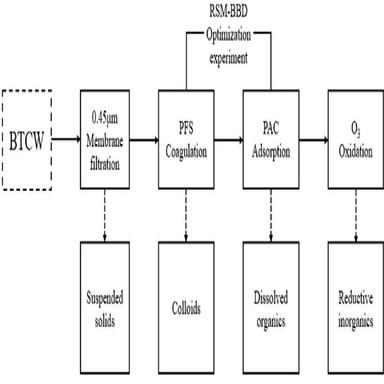
Flowchart of the stepwise process.